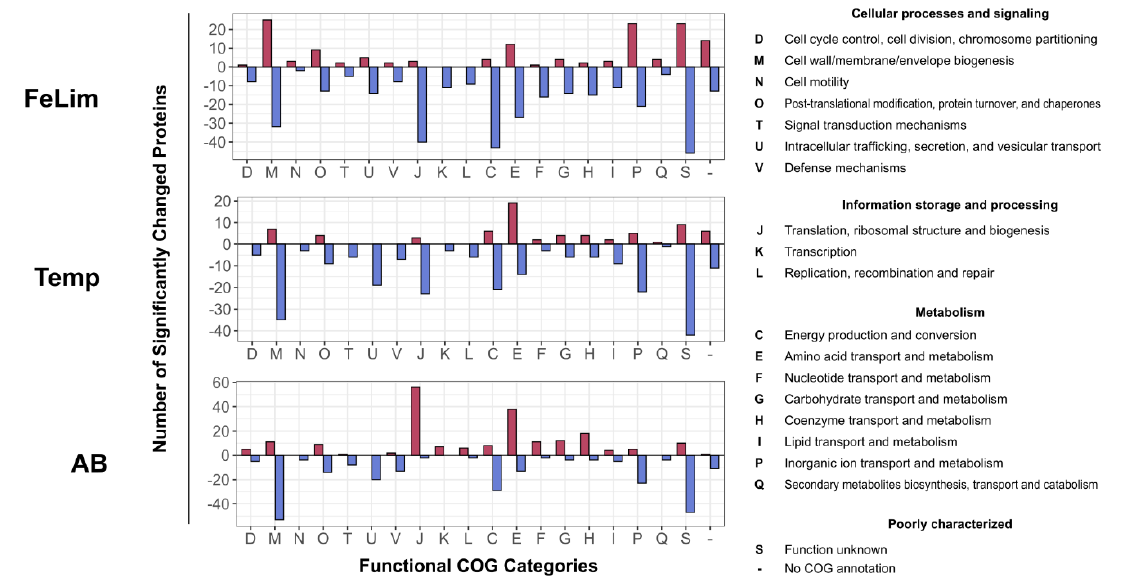
Figure 7. The number of significantly changed proteins for the OMVs derived in the stress conditions. Significantly changed proteins were grouped according to their eggNOG-predicted functional COG categories (FeLim—iron limitation; Temp—elevated temperature stress; AB—antibiotic stress). On the right side are the descriptions of the COG one-letter